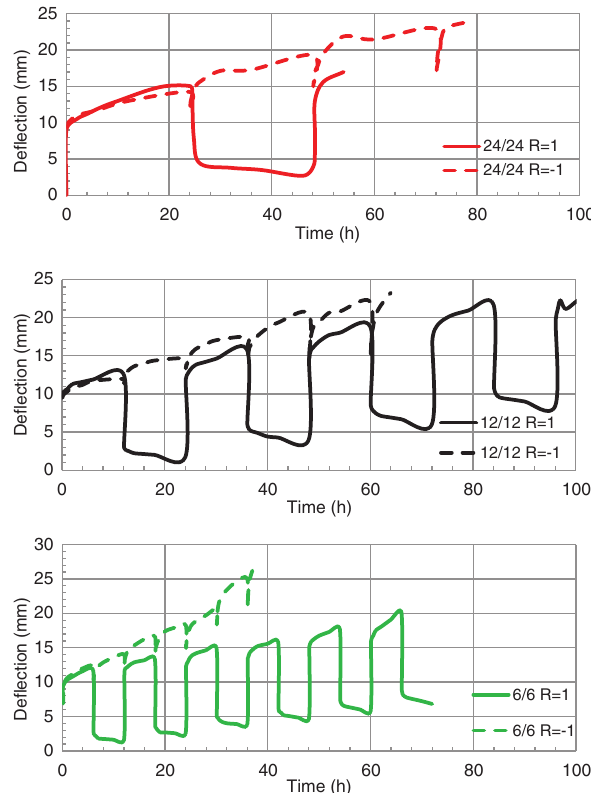
Figure 7: A comparison of R = 1 and R = -1 creep testing results at equal loading and unloading/reverse loading times.